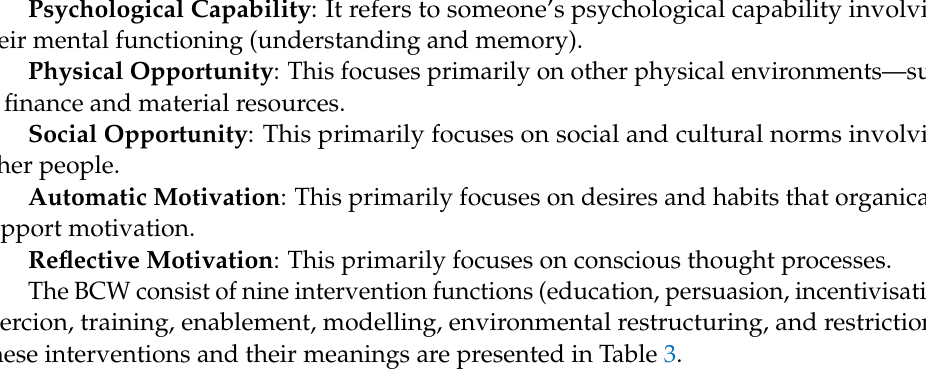
Table 3. The nine different types of intervention included in the